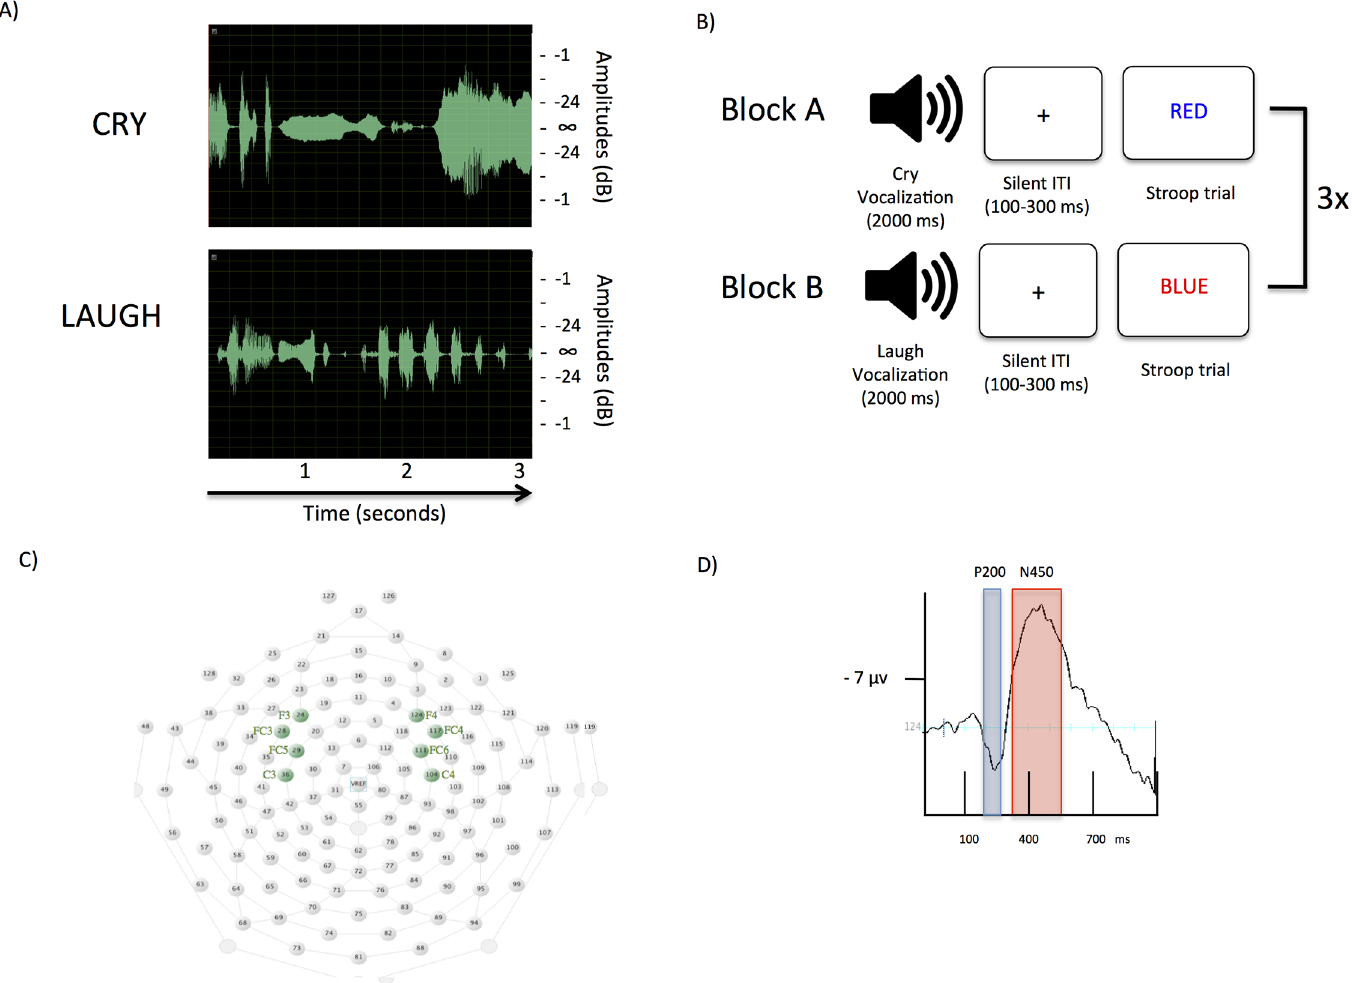
Fig 1. Experimental methods. (A) Amplitudes (dB) of the infant cry and laugh vocalizations. (B) Schematic of the cross-modal distraction paradigm: Block A and B each consist of 24 trials and are repeated three times in an A-B-A-B-A-B design for a total of 144 trials. For each trial, an infant vocalization is presented for 2000 miliseconds (ms) followed by a Stroop trial. The interstimulus interval (ISI) between the vocalization and Stroop trial was 100 – 300 ms and consisted of a fixation cross “ + ” presented in silence. (C) Map of recording electrodes. Electrocortical responses to Stroop trials were analyzed from 8 electrodes (denoted by the green circles), which included the left frontal electrode # 24 (F3), the left frontal-central electrodes # 28 and # 29 (FC3 and FC5), the left central electrode # 36 (C3), the right frontal electrode # 124 (F4), the right frontal-central electrodes # 111 and # 117 (FC4, FC6), and the right central electrode # 104 (C4). (D) The grand average waveform depicting the temporal window for the P200 (128 – 260 ms) and N450 (350 – 550 ms) ERPs at the right frontal electrode #124